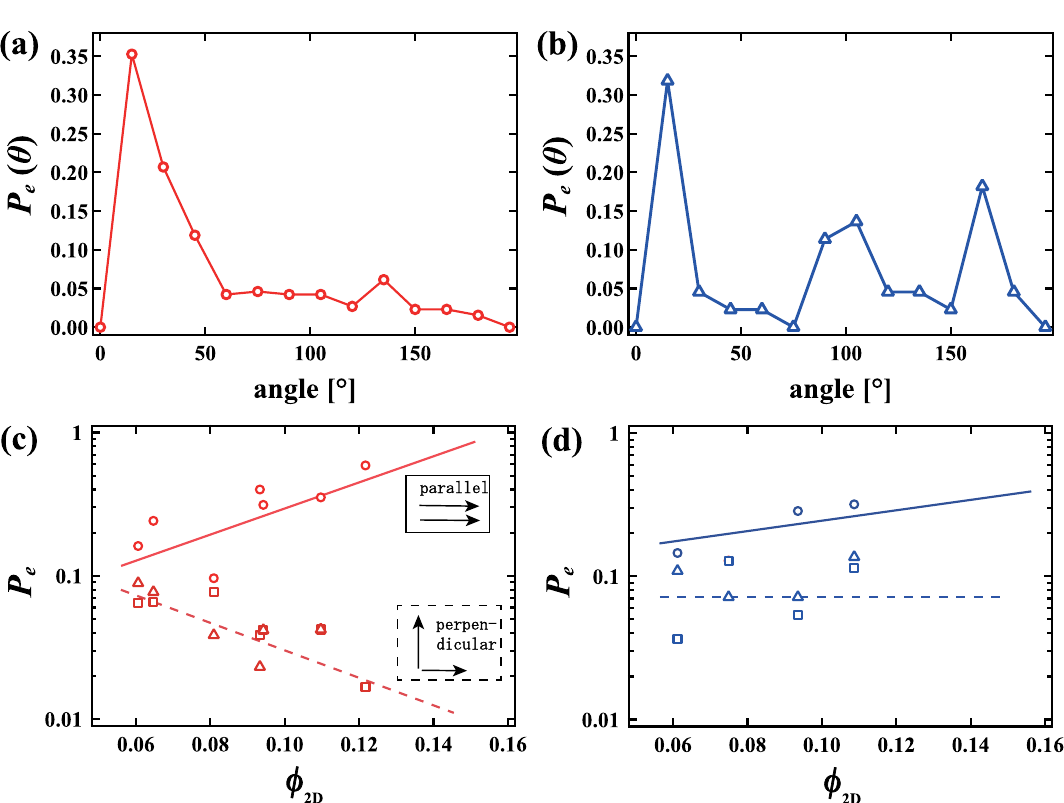
Figure 5. Probability distribution P e (θ) of the angle between displacement vectors of bubbles in contact in collective rearrangement events at ( a ) φ 2 D = 0.11 in a monodisperse foam and ( b ) φ 2 D = 0.11 in a polydisperse foam. P e (θ) has only one peak near θ = 0 for the monodisperse foam, while P e (θ) has another peak around θ = 90° for the polydisperse foam. The probability of parallel and perpendicular displacements as a function of φ 2 D in ( c ) monodisperse and ( d ) polydisperse foams. Circles, squares and triangles indicate probabilities that the angles are 0 ◦ to 15 ◦ , 75 ◦ to 90 ◦ , and 90 ◦ to 105 ◦ , respectively. The solid lines and dashed lines represent slip-like parallel displacements and perpendicular displacements, respectively. Slip-like parallel motion is more likely to be seen closer to the jamming point in monodisperse foams, but is independent of proximity to the jamming point in polydisperse